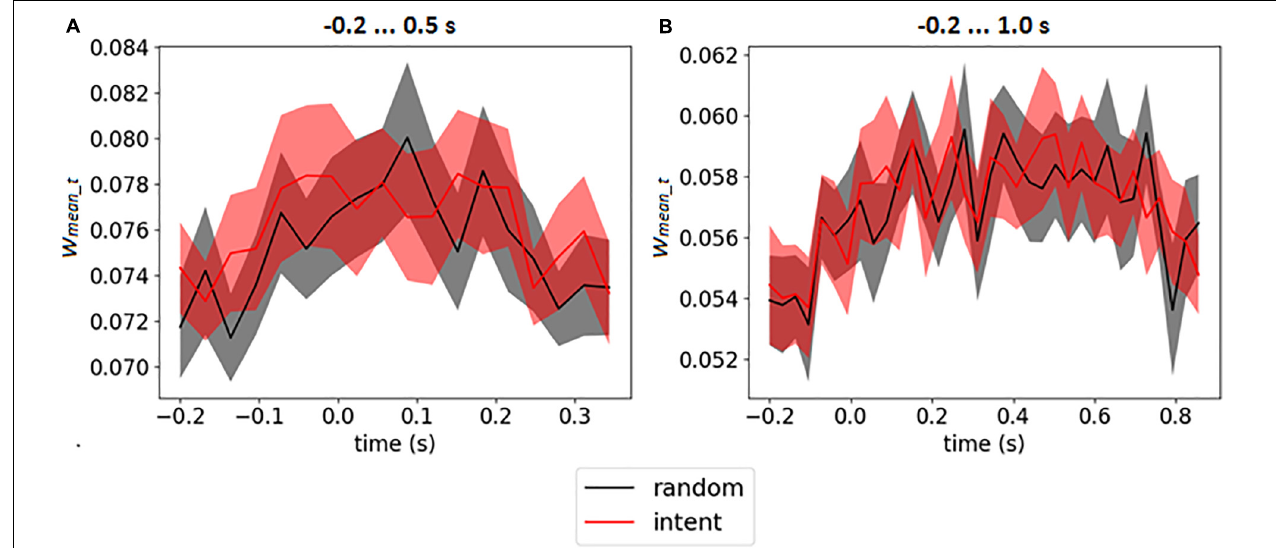
FIGURE 5 | Mean output weights of LF-CNN in every time point averaged over participants for intervals –0.2 ... 0.5 s (A) and 0.2 ... 1.0 s (B) . The filled area corresponds to 95% confidence interval.